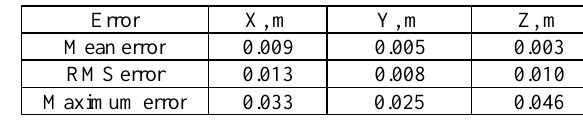
Table 2 . Estimating accuracy of MLS data relative adjustment.